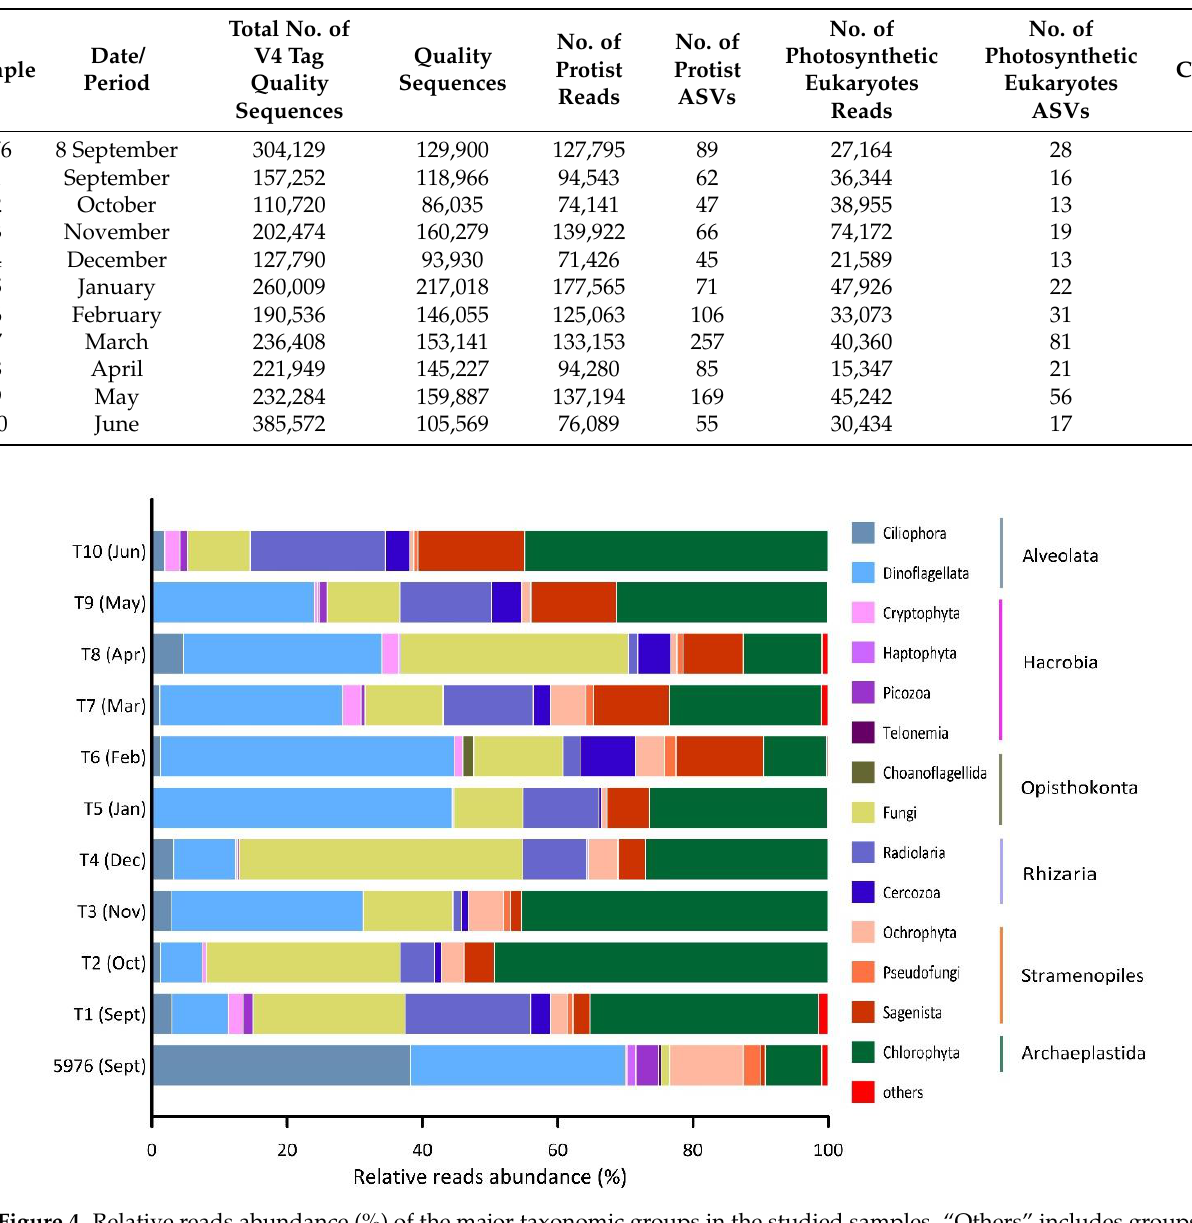
Table 1. Sequencing statistics and estimated PE ASVs richness and diversity index Chao 1 obtained from metabarcoding analysis of one water sample and sediment trap samples in the Kara Sea picoeukaryote communities.